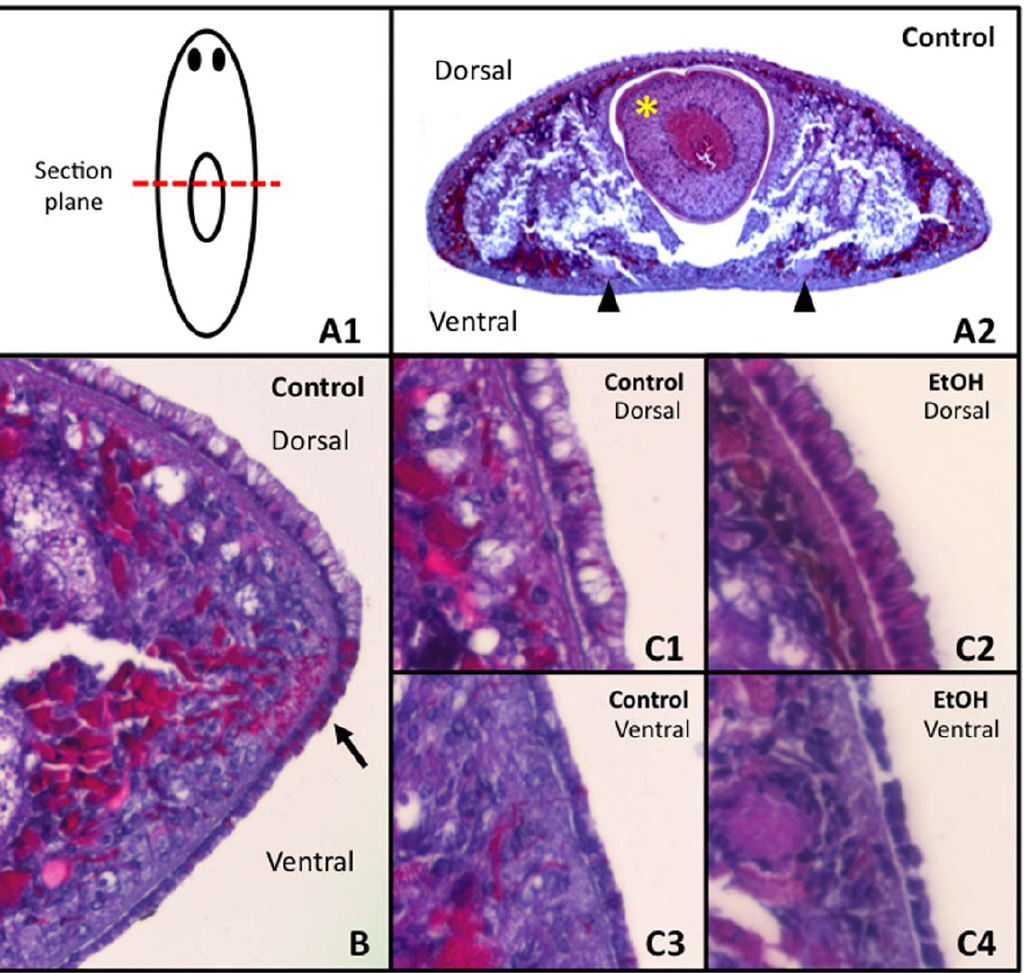
Figure 6. A Short 3% Ethanol Treatment Does Not Cause Epithelial Cell Lysis. H&E Staining Analysis . ( A1 ) Diagram of sections. ( A2 ) Transverse section of control worm. Yellow asterisk = pharynx. Black arrowheads = round ventral nerve cords (which denote the ventral surface). ( B ) Closer view of an untreated control section, illustrating the larger columnar dorsal epithelial cells, the smaller cuboidal ventral epithelial cells, and the adhesive cells that lie at the dorsal/ventral margin which stain bright pink (arrow). ( C1 ) Control dorsal, ( C2 ) EtOH-treated dorsal, ( C3 ) control ventral and ( C4 ) EtOH-treated ventral epithelia showing that EtOH treatment does not disrupt epithelial cell membranes.